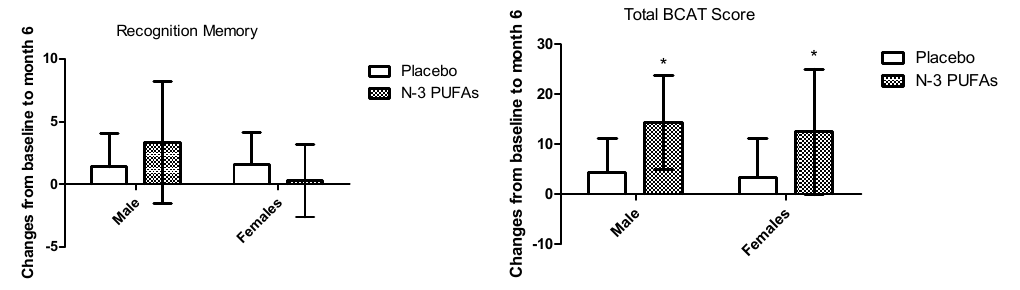
Figure 2. Changes in perceptual speed, mental arithmetic efficiency, space imagery efficiency, working memory, and recognition memory between n ‐ 3 PUFAs and control groups stratified by sex. Data represent mean changes over 6 months with SD. The n ‐ 3 PUFAs effect and significance level are based on independent samples t tests.